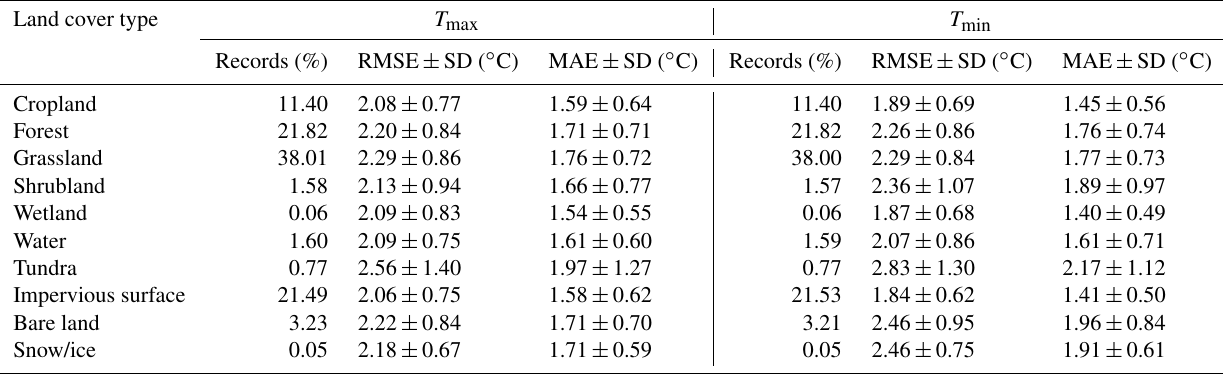
Table 2. Model performance for different land cover types in 2003–2020.